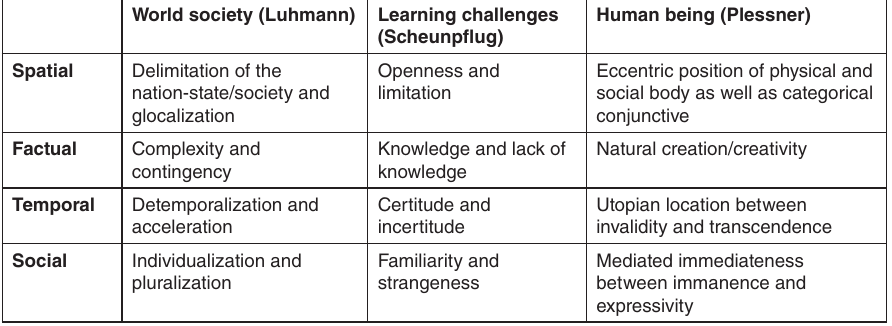
(Scheunpflug) Openness and limitation